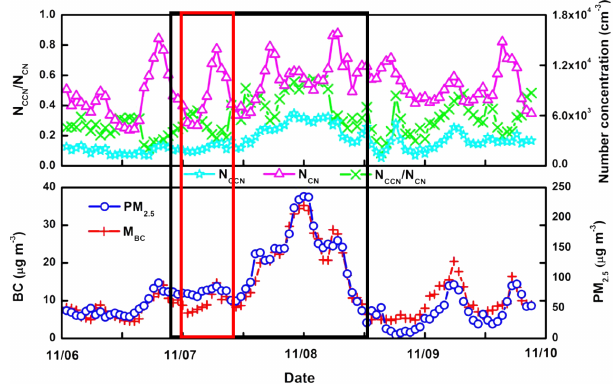
Figure 6. Temporal variations of particle water soluble ion compo- sition and trace gases, the foggy–hazy case is marked in red open boxes and hazy case in black.